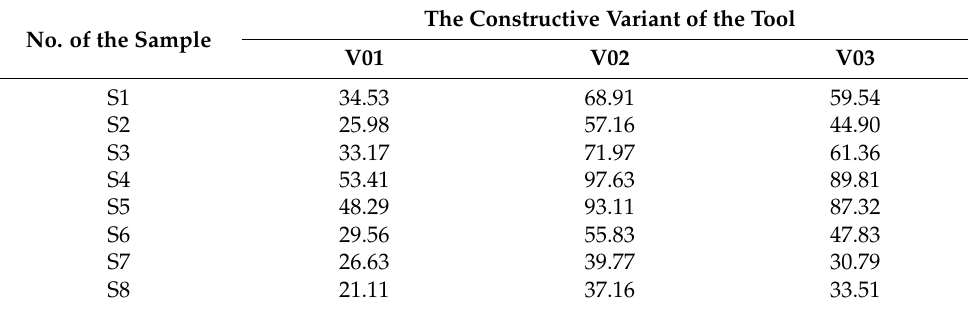
Table 6. The medium values of F p component for the 3 variants of cutting tools, daN. No. of the